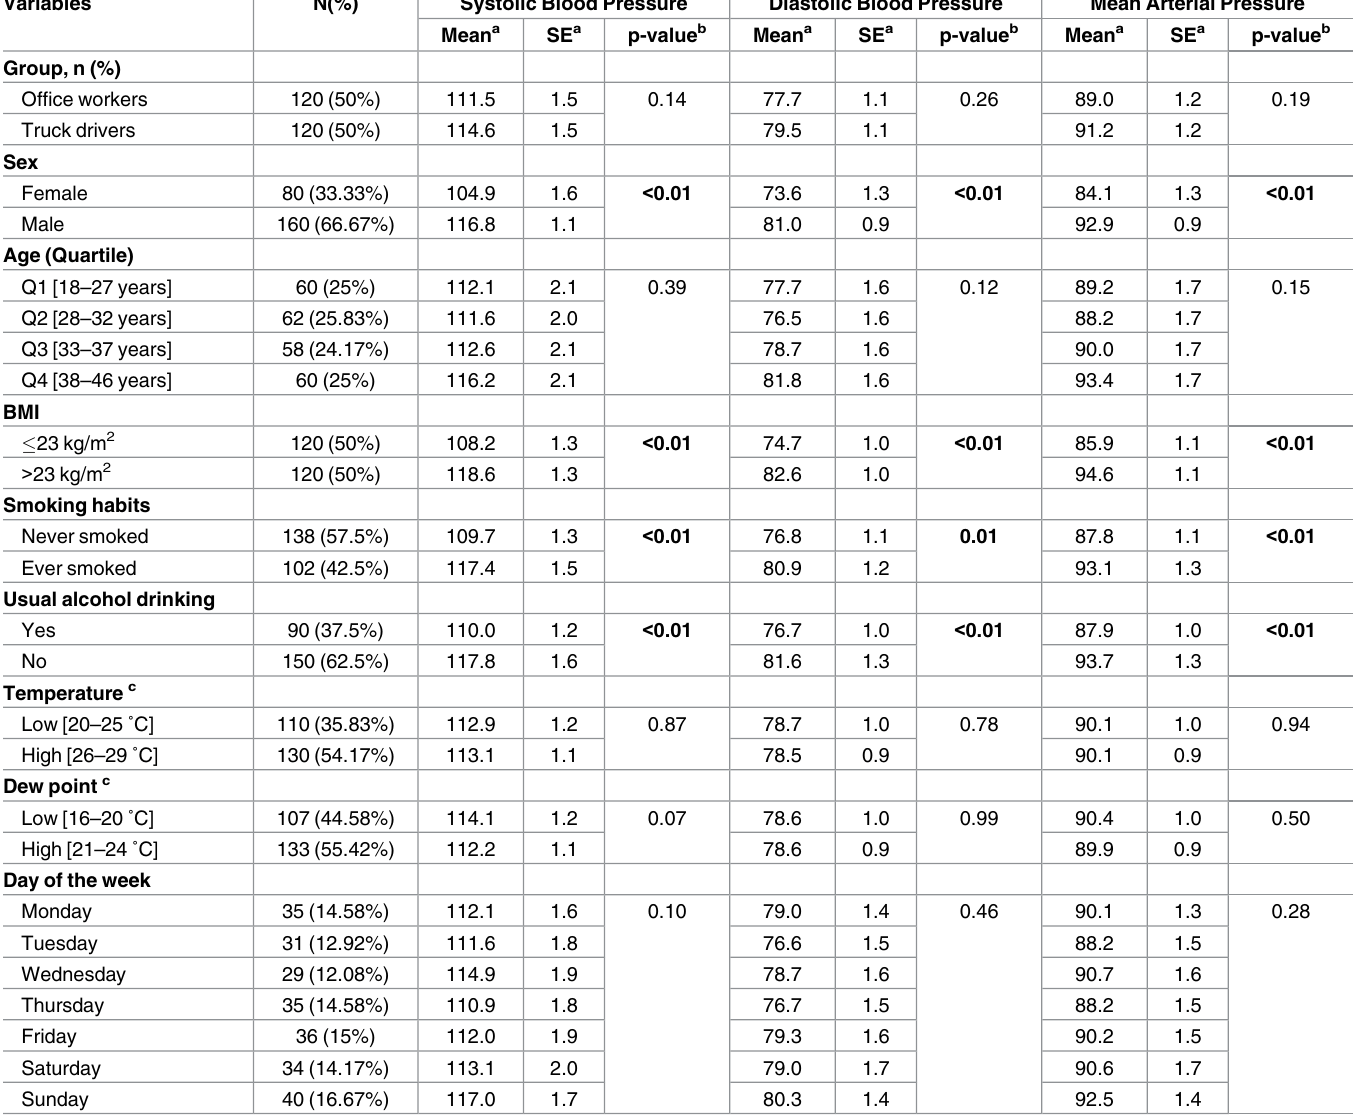
a Means and standard error of blood pressure and heart rate measured on two examination days were estimated by marginal means and corresponding standard error from mixed-effects regression models. b p-values were calculated using mixed-effects regression models.